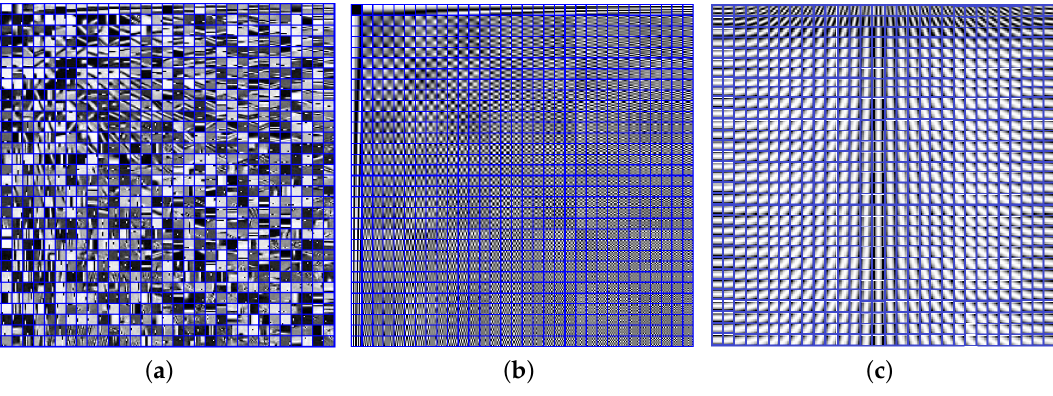
Figure 2. Our pre-learned dictionary of ridge maps ( a ), discrete cosine transform (DCT) dictionary (or say basis) ( b ), and Gabor wavelet dictionary (or say basis) ( c